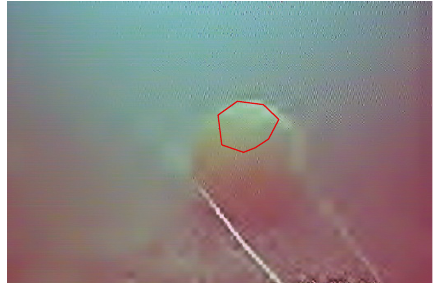
Figure 16: Segmentation of a mine at sea with pre-processing and segmentation using RGB information. C good = 0 . 2 and C false = 0.